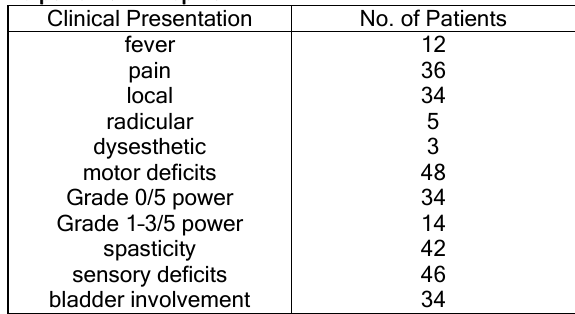
Table 1.Summary of presenting signs and symptoms in 48 patients with spinal TB Clinical Presentation